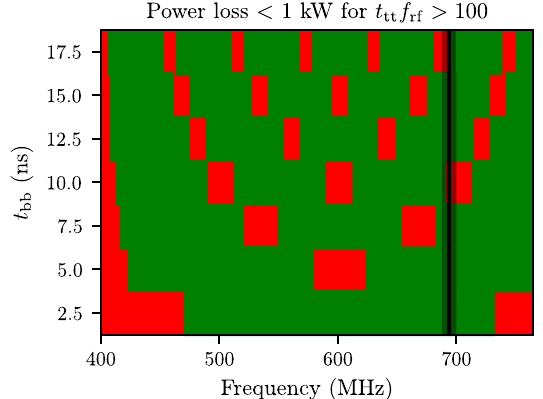
FIG. 21. Frequency ranges with acceptable power loss below 1 kW for different bunch spacings (green regions). Regions with power loss above 1 kW are shown with red color. The vertical black line corresponds to the position of HOM in the single-cell cavity with the maximum frequency shift of (cid:3) 5 MHz. The considered frequency range is limited by the frequency of the fundamental mode (400.79 MHz) and the cutoff frequency (765 Fig. 21. These regions are different for different t